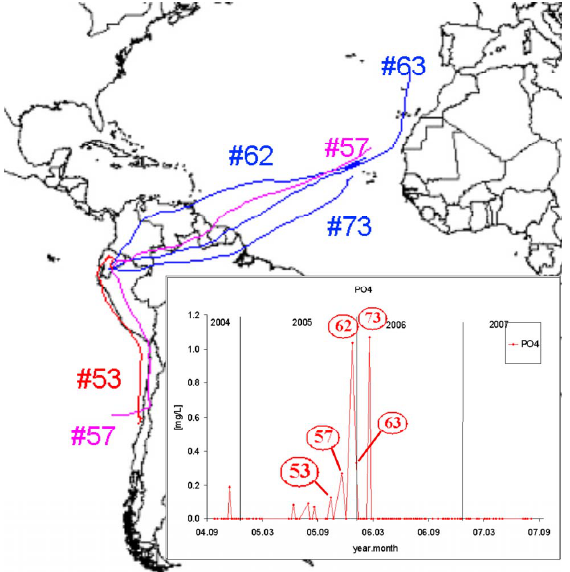
Fig. 14. 10-days back trajectories for dominant PO 4 peaks which are also